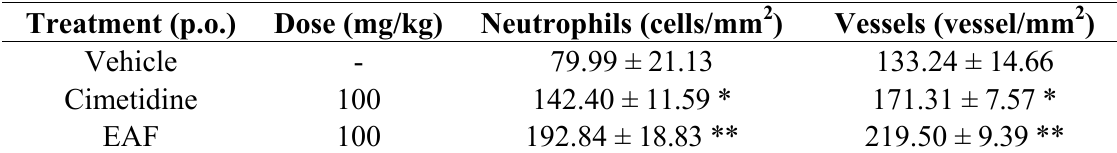
Table 3. Number of neutrophils and vessels in regenerative mucosal regions in rats with acetic acid-induced ulcer after a 14-day treatment with ethyl acetate fraction (EAF) from Alchornea triplinervia (100 mg/kg/day).